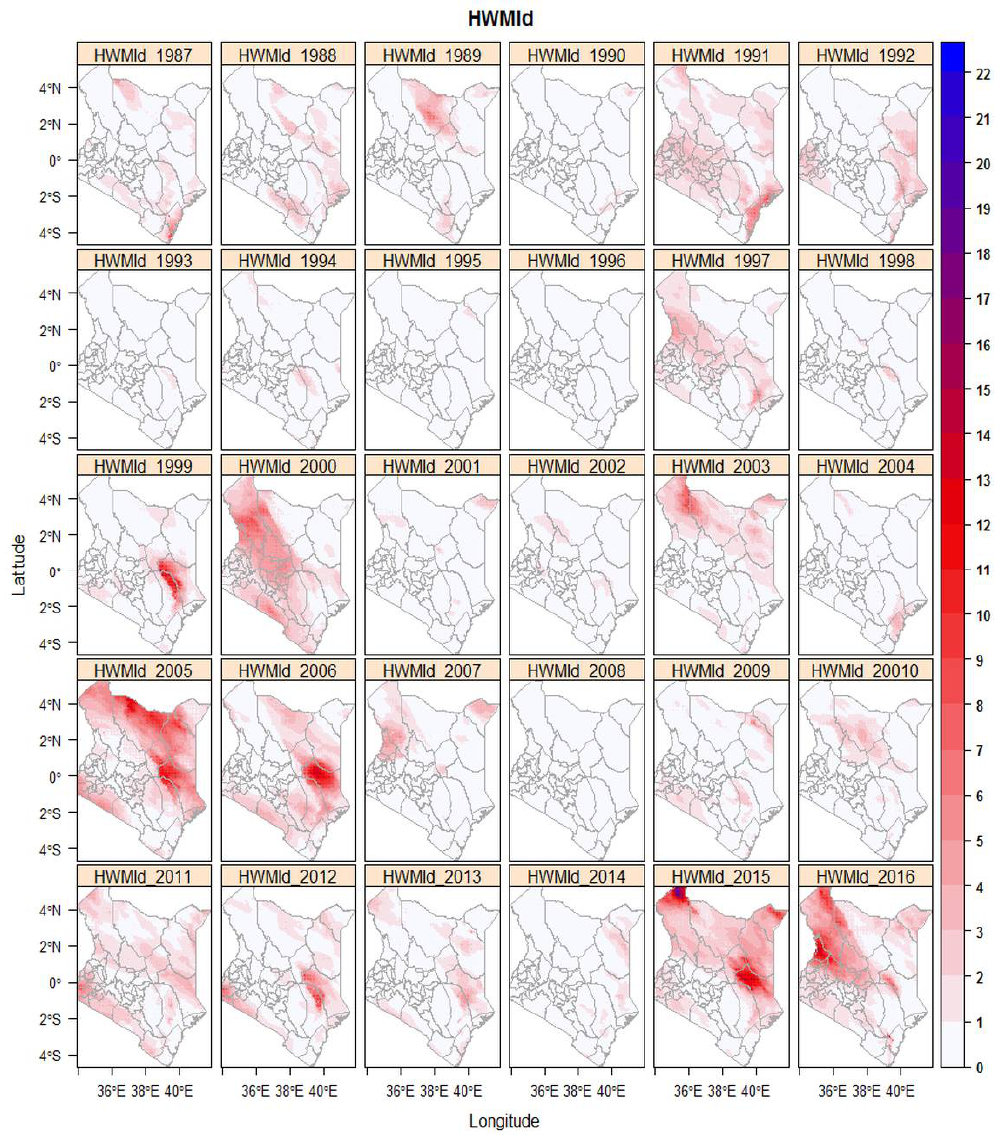
Figure 2. Heatwave Magnitude Index daily (HWMId) 1987–2016. The white (0) indicates no heatwave event.